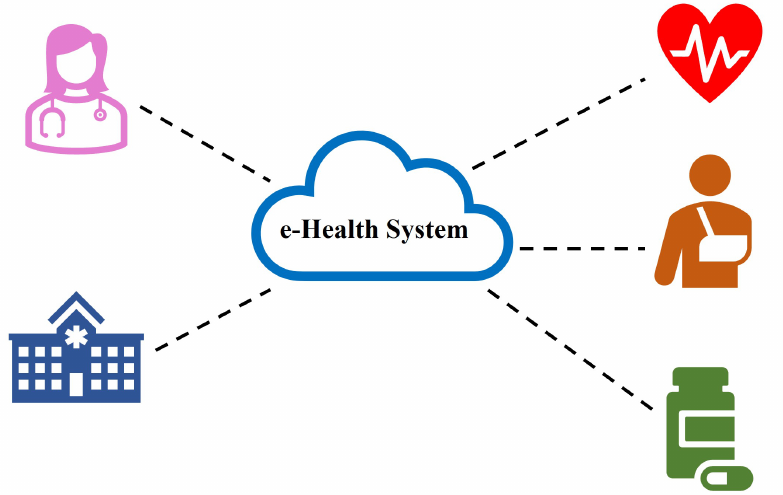
Figure 10. e-Health applications offer quick and safe access for both doctors and patients, resulting in better advice and